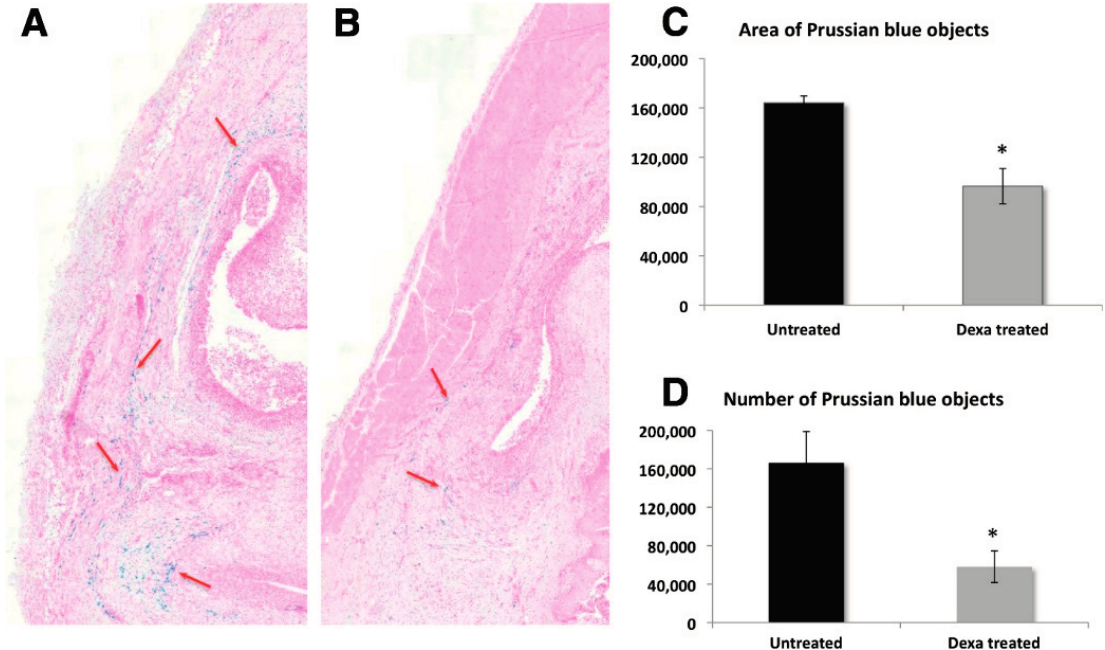
Figure 3. Distribution and quantification of Prussian blue stained superparamagnetic iron oxide nanoparticles (SPIONs) on day 13 post-antigen-induced arthritis (AIA) induction. Photomicrographs of Prussian-blue-stained sections showing an example of the distribution of SPIONs (red arrows) in the synovium of untreated animal ( A ) versus a Dexa-treated animal ( B ) on day 13 post-AIA induction at 1.5 times magnification. Quantification of the area ( C ) and number ( D ) of Prussian-blue-stained SPIONs on day 13 post-AIA induction. Photomicrographs of Prussian-blue-stained sections were scanned, and the images were analyzed for the area ( C ) and the number ( D ) of SPIONs using Tissue Studio® software. Four sections were quantified and averaged per animal. Data points are mean ± standard error of the mean and n = 5 per group. * p = 0.005 ( A ) and 0.016 ( B ) compared to the untreated control group. Reprinted with permission from Gramoun et al. [141] Copyright 2014 Biomed Central